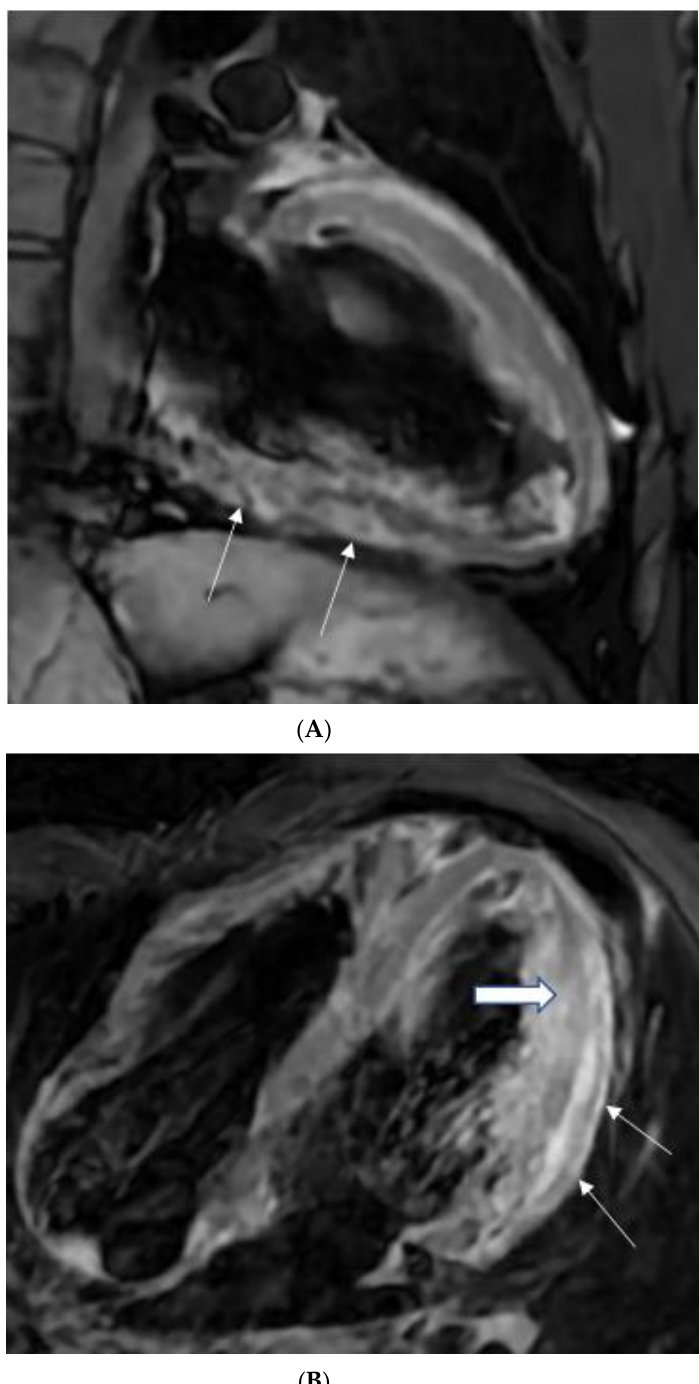
Figure 1. ( A ) A 35-year-old male with a recent history of treated tuberculous pericarditis for six months had CMR for ventricular tachycardia. 2CH T2w STIR pictures demonstrate increased epicardial and transmural signals in the inferior wall (arrows). ( B ) A 35-year-old male with a recent history of treated tuberculous pericarditis for six months had CMR for ventricular tachycardia. 4CH T2w STIR pictures demonstrate irregular thickening of the pericardium (small arrows) with the increased transmural signal of the mid-lateral wall (thick